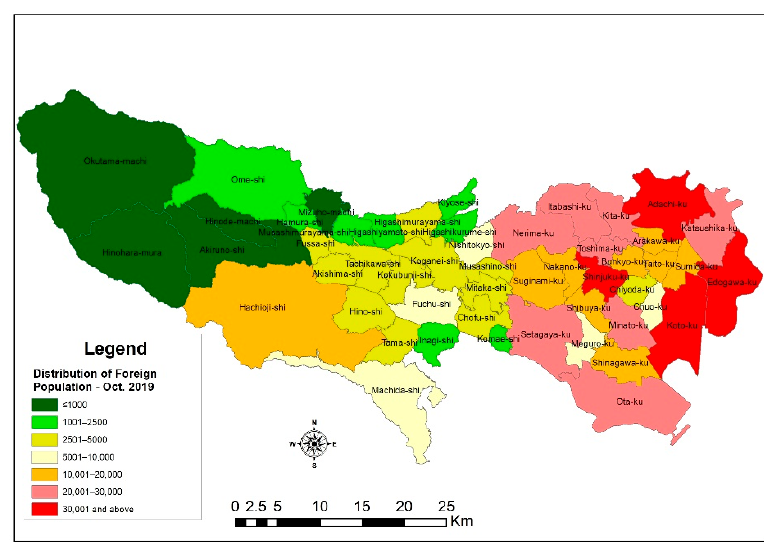
Figure 3. Distribution of non-Japanese nationals in the Tokyo metropolitan area.